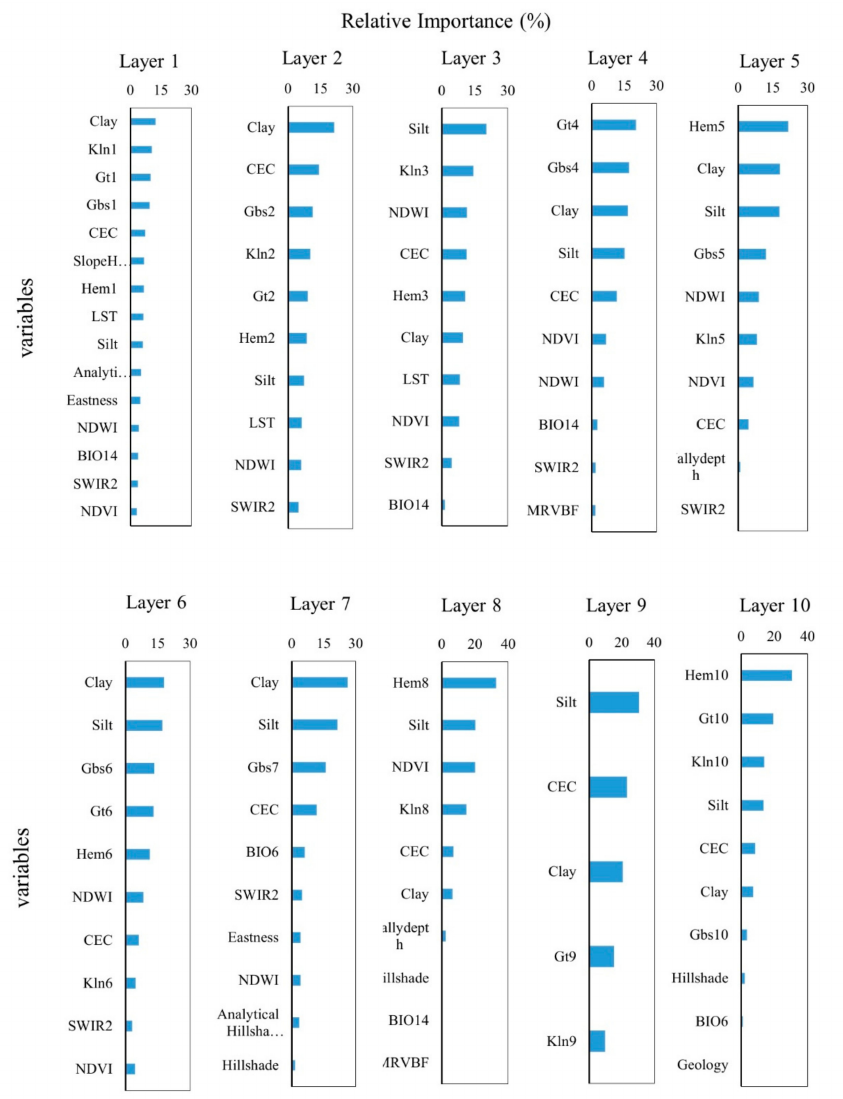
Figure 7. Variable importance for SOC stocks prediction in different depth at Pas = 100 class by random